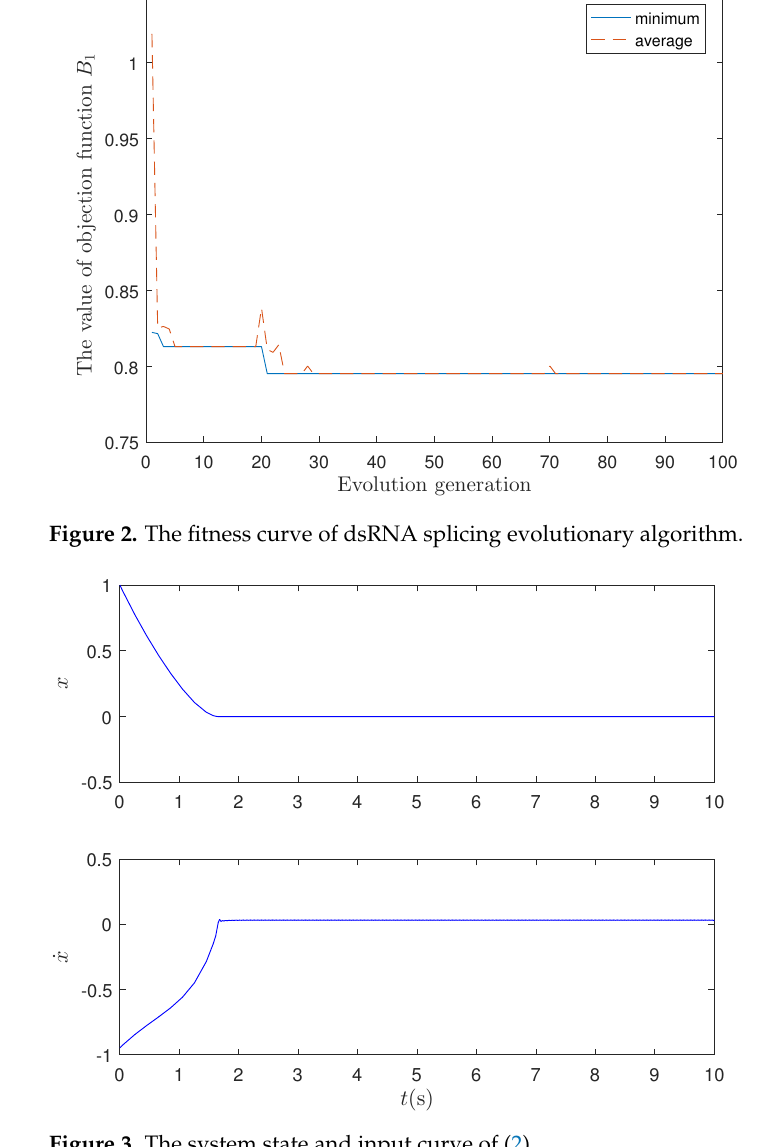
Figure 3. The system state and input curve of